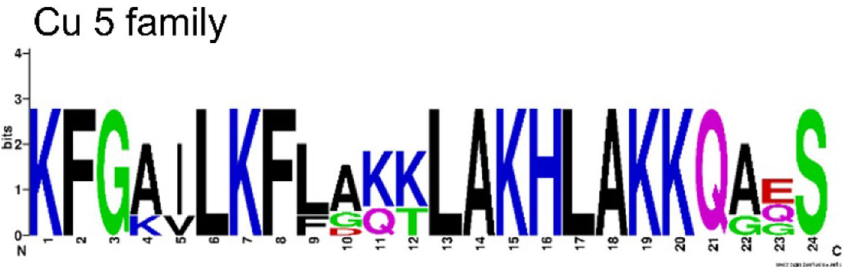
Figure 5. Amino acid sequence logo of the Cu 5 family. The relative frequency of each amino acid residue at a certain position of different cupiennin families is given as sequence logo. Cationic amino acids are colored in blue, anionic amino acids in red, the corresponding C-terminal amid variants in pink, polar amino acids in green, and hydrophobic amino acids in black.